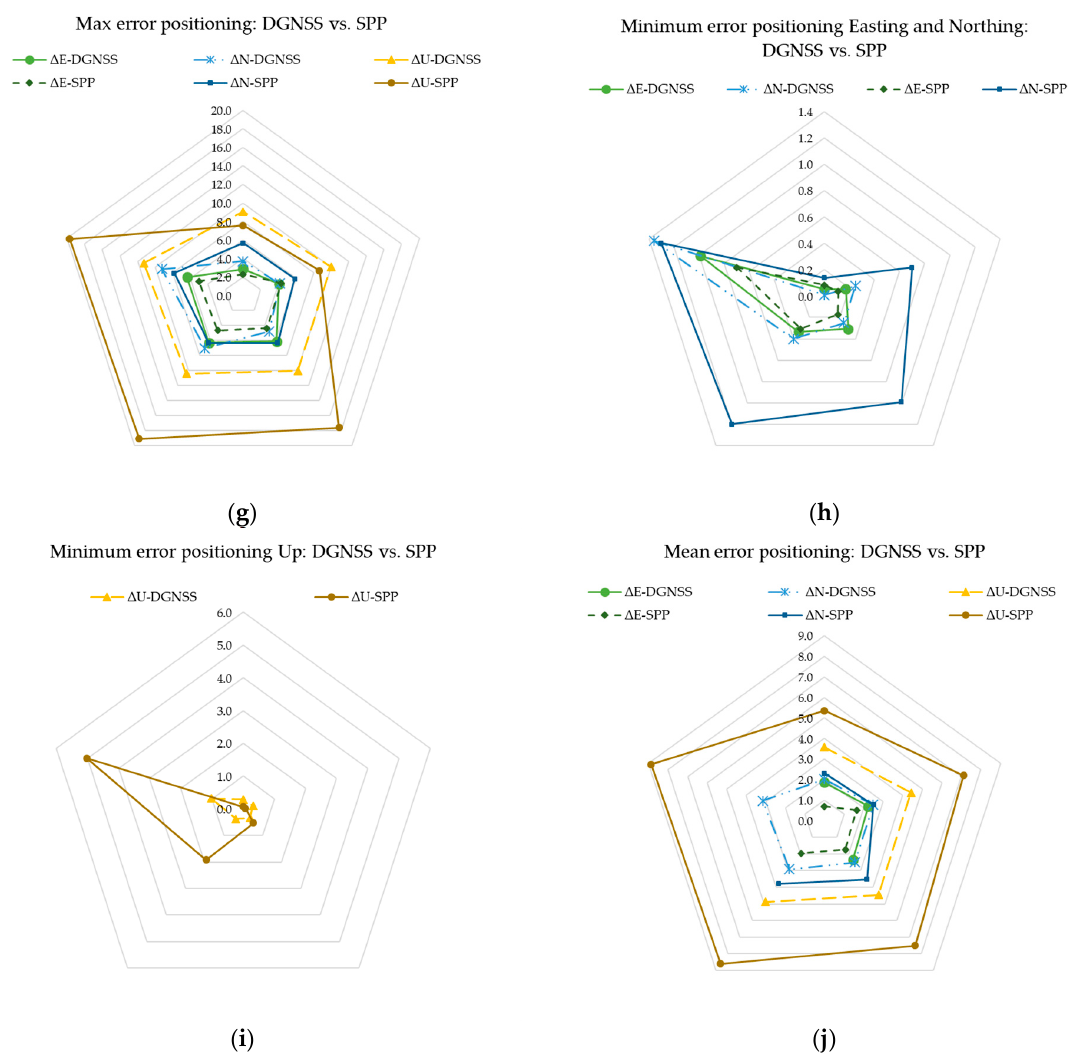
Figure A7. Comparison of the positioning errors of the sub ‐ datasets Δ E, Δ N, Δ U: ( a ) total DGNSS positioning error for the sub ‐ dataset Δ E, ( b ) total SPP error for the sub ‐ dataset Δ E, ( c ) total DGNSS positioning error for the sub ‐ dataset Δ N, ( d ) total SPP error for the sub ‐ dataset Δ N, ( e ) total DGNSS positioning error for the sub ‐ dataset Δ U, ( f ) total SPP error for the sub ‐ dataset Δ U, ( g ) comparison between the maximum positioning errors for all observation times, ( h ) comparison between the minimum planimetric positioning errors for all observation times, ( i ) comparison between the minimum up positioning errors for all observation times, ( j ) comparison between the mean positioning errors for all observation times.